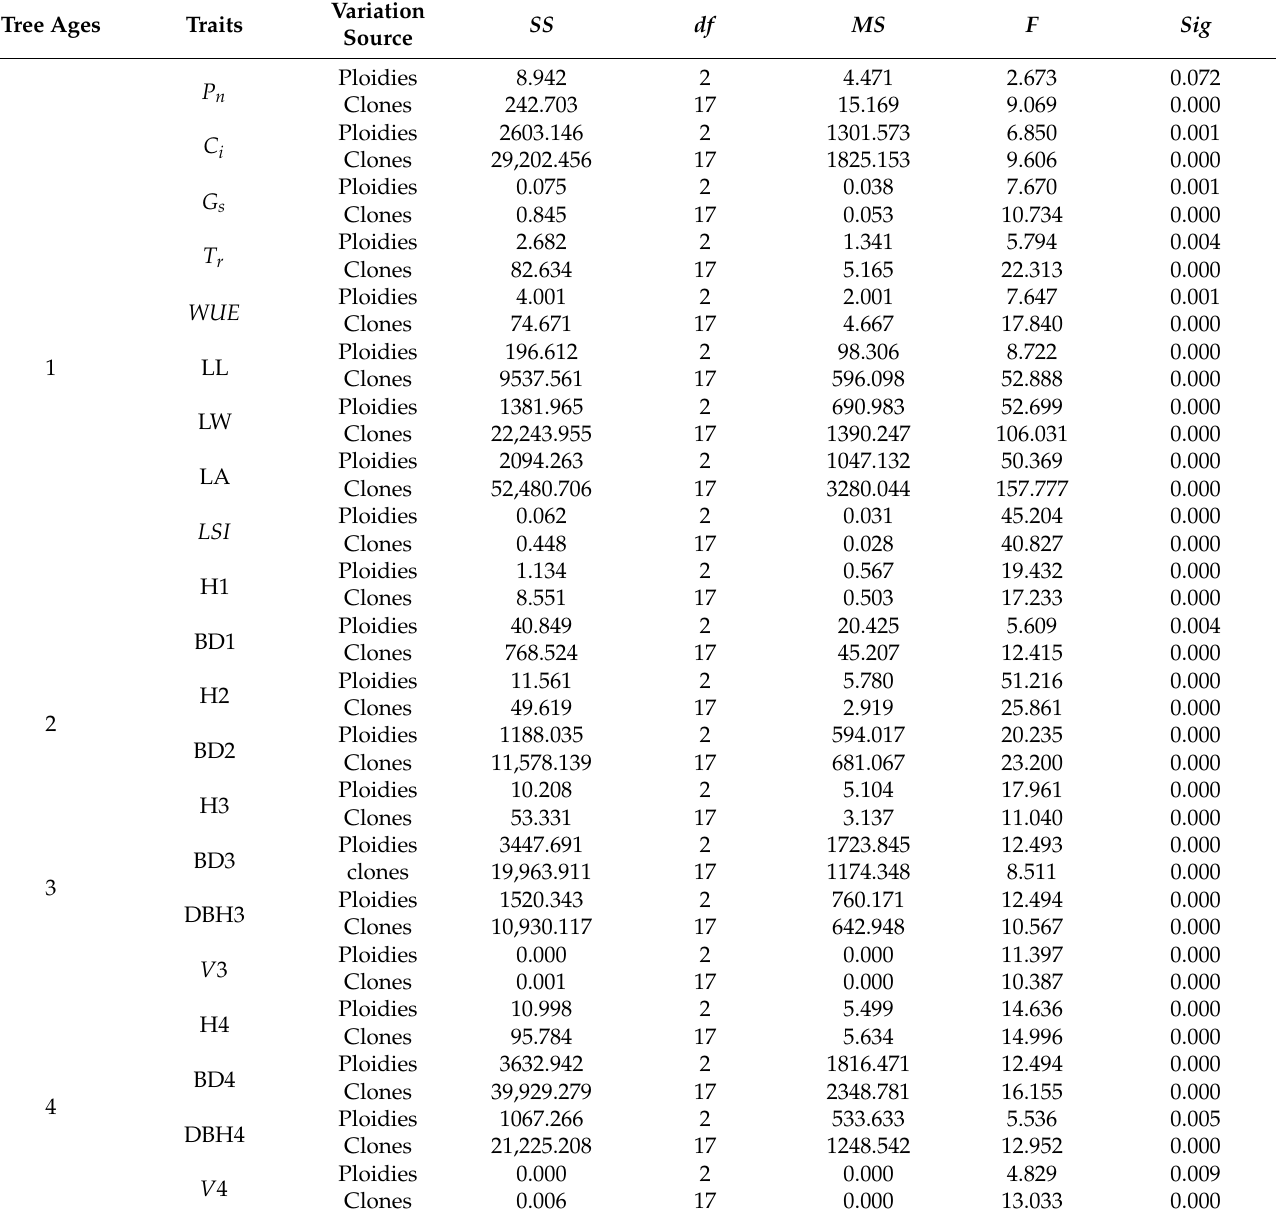
Table 2. Variation analysis of growth